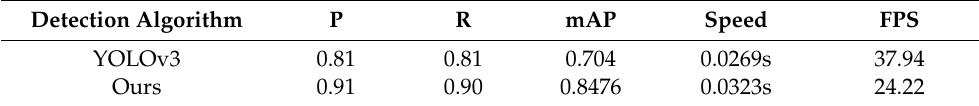
Table 2. Comparisons of YOLOv3 Detection Results before and after Improvements